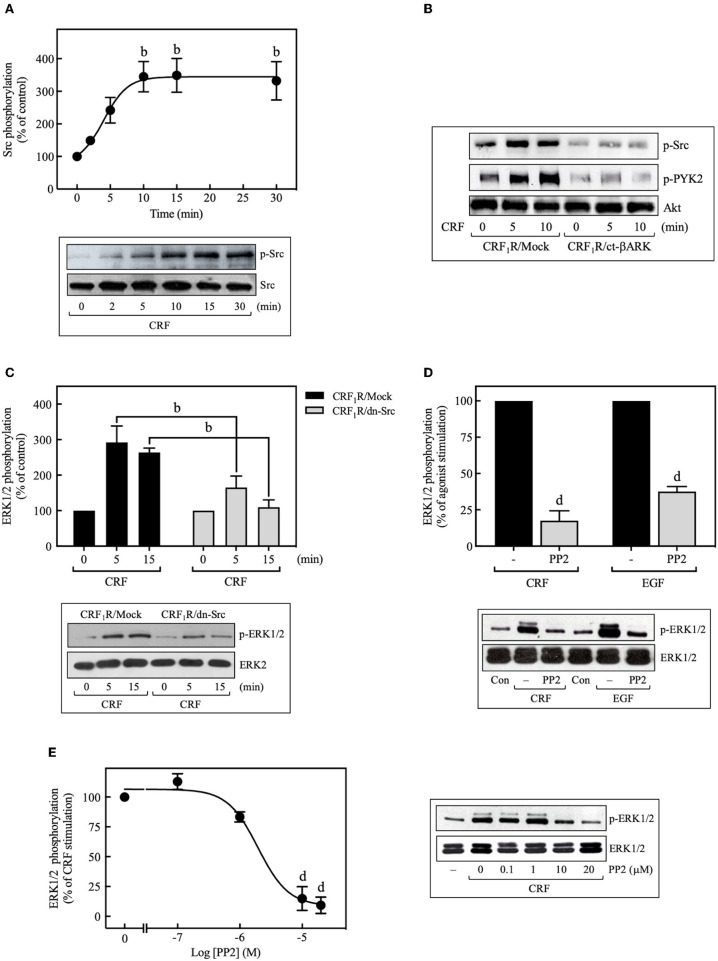
Role of Src tyrosine kinase in CRF-stimulated ERK1/2 phosphorylation. (A) COS-7 cells expressing HA-CRF1Rs were stimulated with 100 nM CRF for the indicated times. (B) COS-7 cells co-transfected with a plasmid pRK5 encoding the carboxyl terminus of βARK that contains its βγ-binding domain (ct-βARK) or an empty control vector (Mock) and the pcDNA3-HA-CRF1R expression vector were stimulated with 100 nM CRF for 5 or 10 min. (C) COS-7 cells co-transfected with a dominant-negative SrcYF-KM (dn-Src) expression vector or an empty control vector (Mock) and the pcDNA3-HA-CRF1R expression vector were stimulated with 100 nM CRF for 5 or 15 min. Cells were pretreated with 10 μM or the indicated concentrations of PP2 for 30 min before stimulation with 100 nM CRF (5 min) (D,E) or 10 ng/ml EGF (10 min) (D). Total cell lysates were separated by SDS-PAGE and analyzed by immunoblotting with anti-p-Src Tyr416
(A,B) or anti-p-ERK1/2 Thr202/Tyr204
(C–E), as described in Materials and Methods. Src, PYK2, and ERK1/2 phosphorylation were quantitated by densitometry, and mean values were plotted from three to five independent experiments. Vertical lines represent the S.E.M. Western blots were also probed for total Src, total Akt, and total ERK showing equal loading. (A)
bp < 0.01 vs. 0 min. (C)
bp < 0.01 vs. CRF1R/Mock (5 or 15 min). (D)
dp < 0.0001 vs. CRF (–), dp < 0.0001 vs. EGF (–). (E)
dp < 0.0001 vs. 0 M.